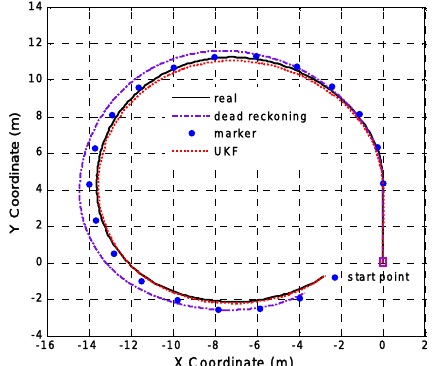
Fig. 5. Localization Results without Fault Marker